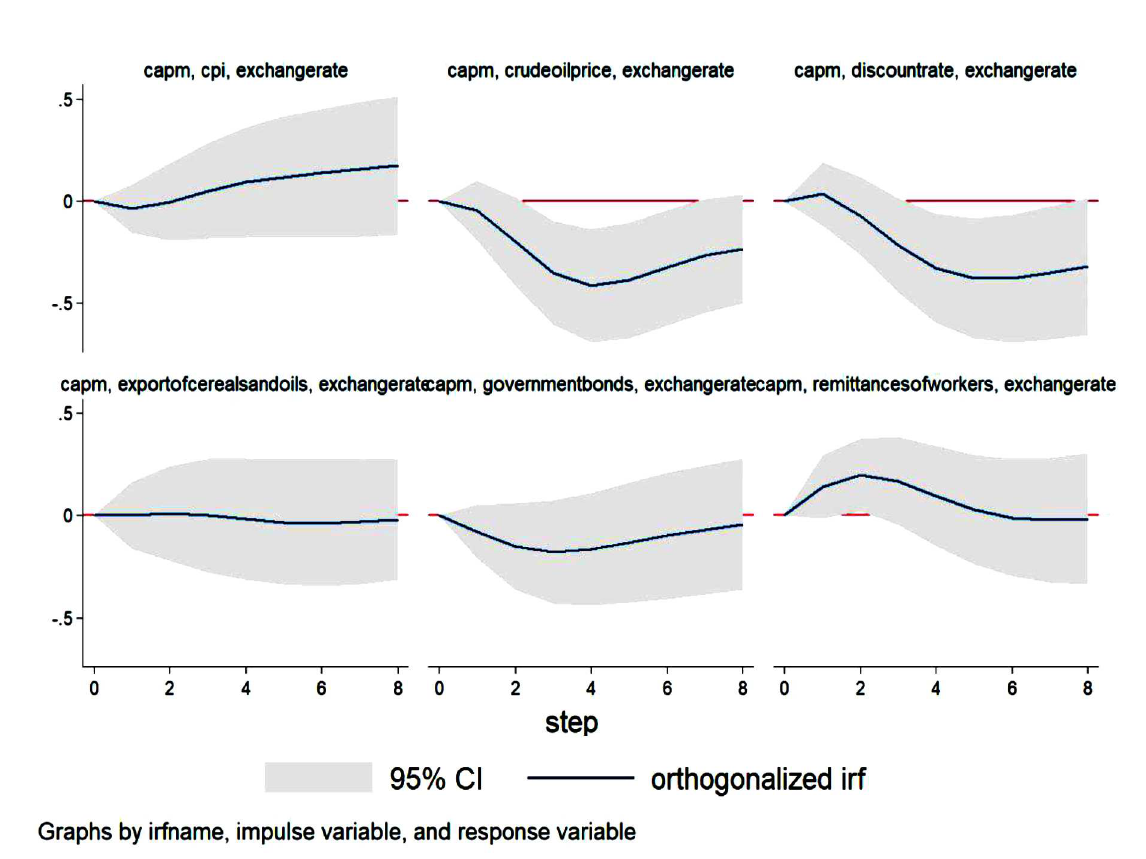
Figure D1. Impulse response functions for the VAR (2)